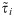
Spatial distribution of the neighbor set LIMA τ~i of six consecutive pairs of the six hours per day periods in Jianghan, Wuhan, China: (a) 2–6 to 6–10; (b) 6–10 to 10–14; (c) 10–14 to 14–18; (d) 14–18 to 18–22; (e) 18–22 to 22–2; and (f) 22–2 to 2–6.